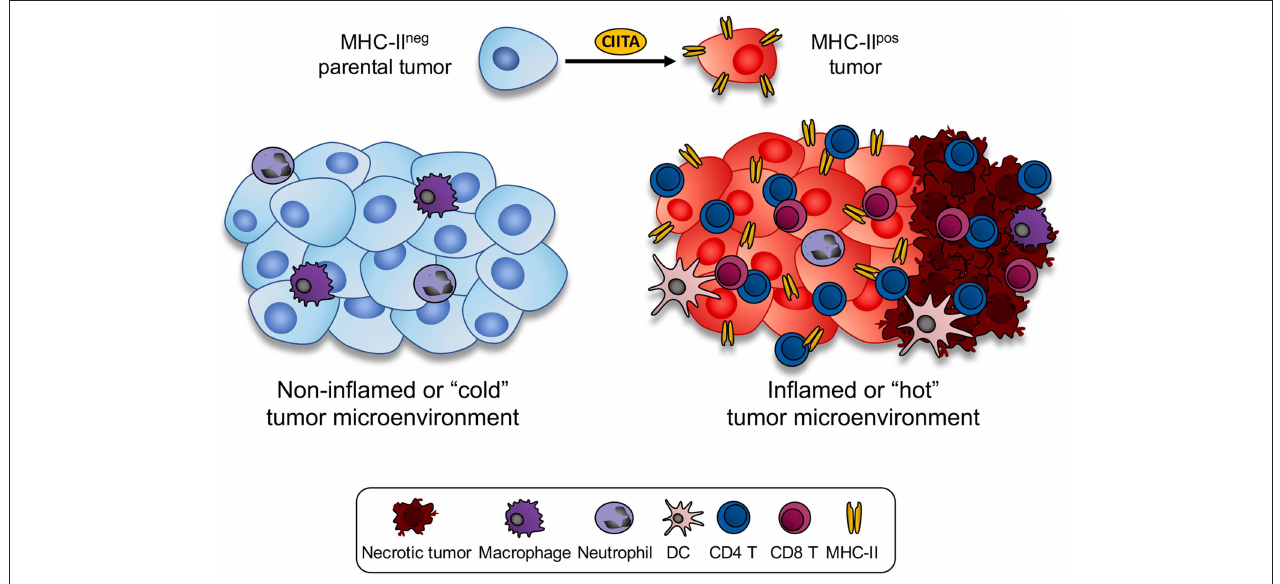
FIGURE 1 | Expression of CIITA-driven MHC-II expression in tumor cells drastically modify the histology of the tumor microenvironment. MHC class II negative mouse tumors of distinct histologic origin and H-2 genotype (left side) are very little infiltrated by blood-derived cells (cold or non-inflamed tumor). In the mouse tumor models analyzed in our studies, scarce infiltration of neutrophils and monocyte-macrophages was detected in vivo in the microenvironment of parental tumors. Upon stable transfection with CIITA and consequent expression of MHC class II molecule, tumors became rapidly infiltrated by CD4 + T cells, followed by CD8 + T cells and only later by dendritic cells and macrophages (inflamed or hot tumor). As result of the intense lymphocyte infiltration, large areas of tumor necrosis were generated. Thus, the tumor microenvironment was drastically modified by the CIITA-driven MHC class II expression in the tumor